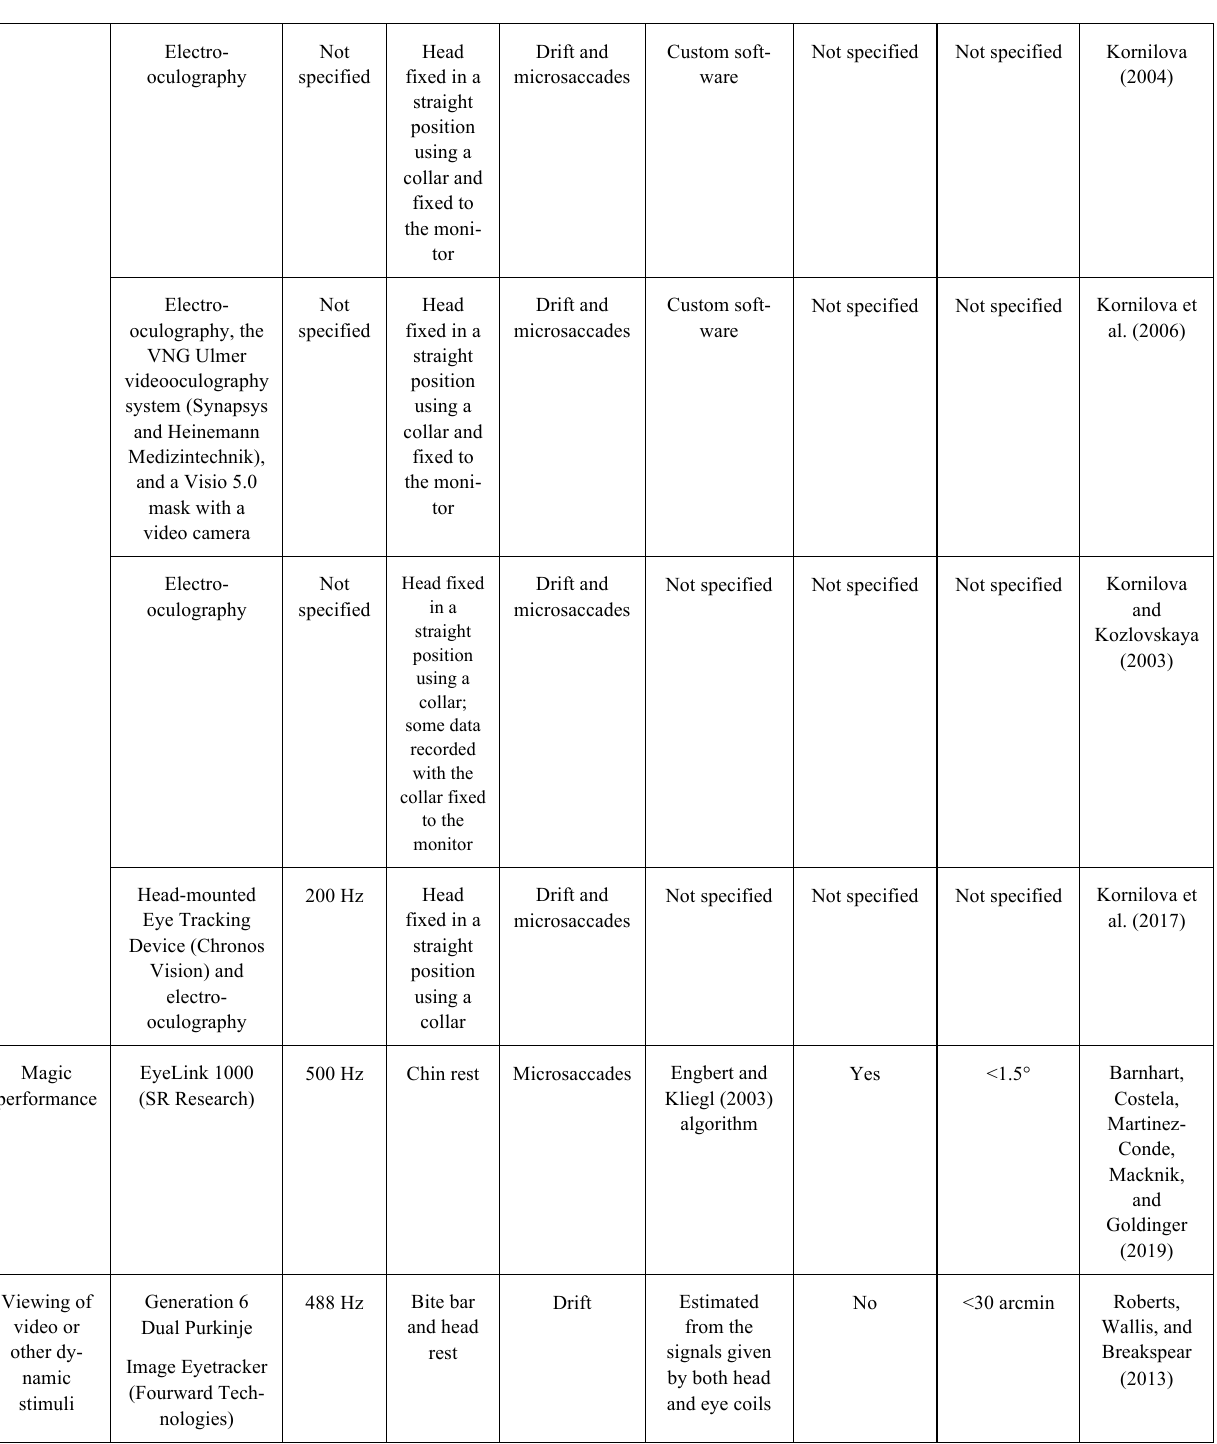
Table 1. Comparison of eye-tracking methods and FEM detection in applied